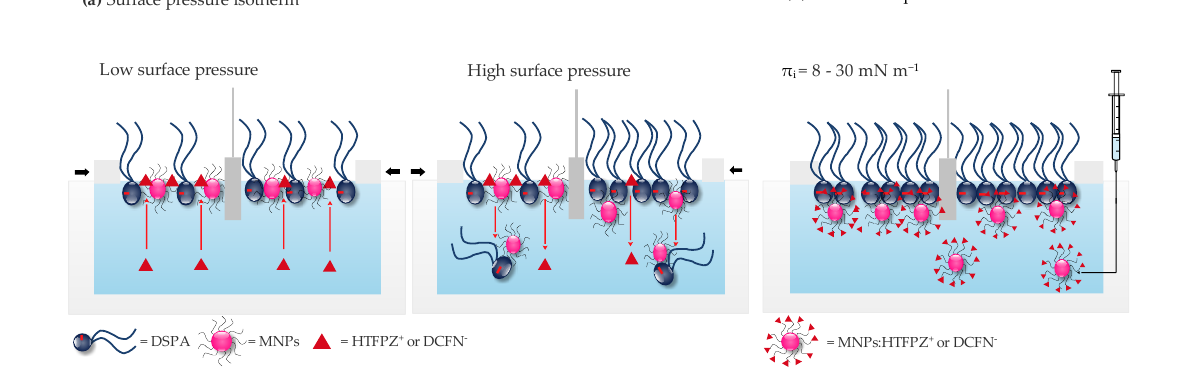
Scheme 2. Schematic representation of ( a ) surface pressure – area isotherm experiments and ( b ) insertions experiments.